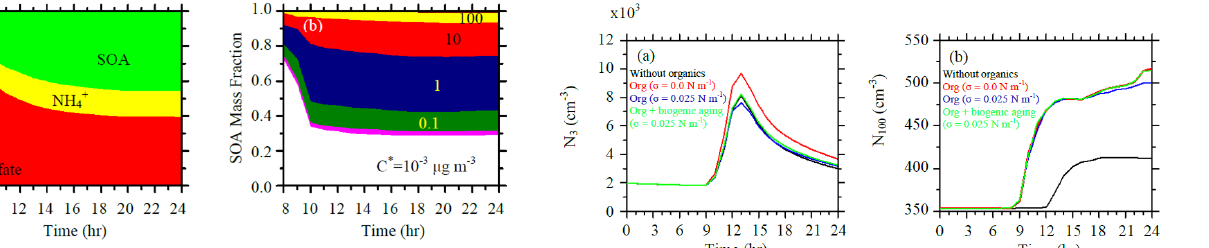
Figure 7. Predicted concentrations of (a) N 3 and (b) N 100 at Hyytiälä for the four simulated cases. Black line represents no condensation of organics, red is with condensation of organics with σ = 0.0Nm − 1 , blue is with condensation of organics with σ = 0.025Nm − 1 , and green is condensation of organics with aging reactions of bSOA precursors and σ = 0.025Nm − 1